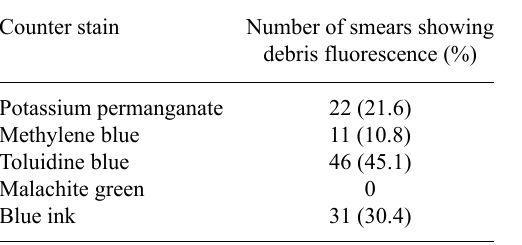
Table 4. Frequency of debris fluorescence using different counter